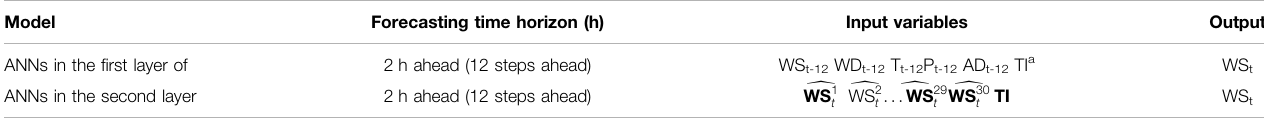
TABLE 3 | Input-output pairs for ANN model.